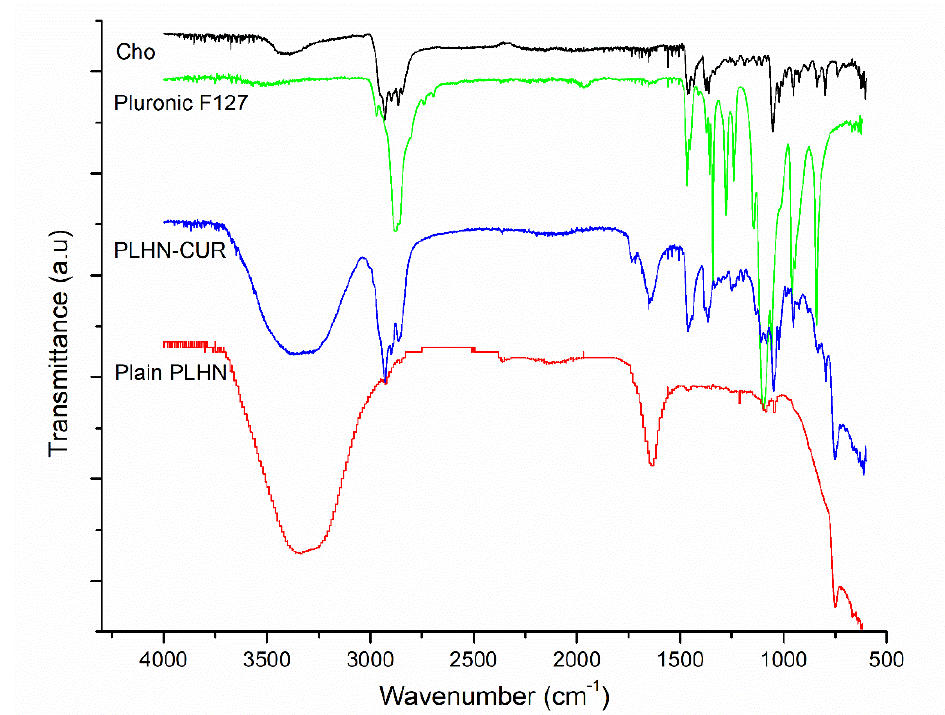
Figure 3. FT–IR spectra of PLHNs main components, CUR–loaded PLHNs and plain PLHNs.